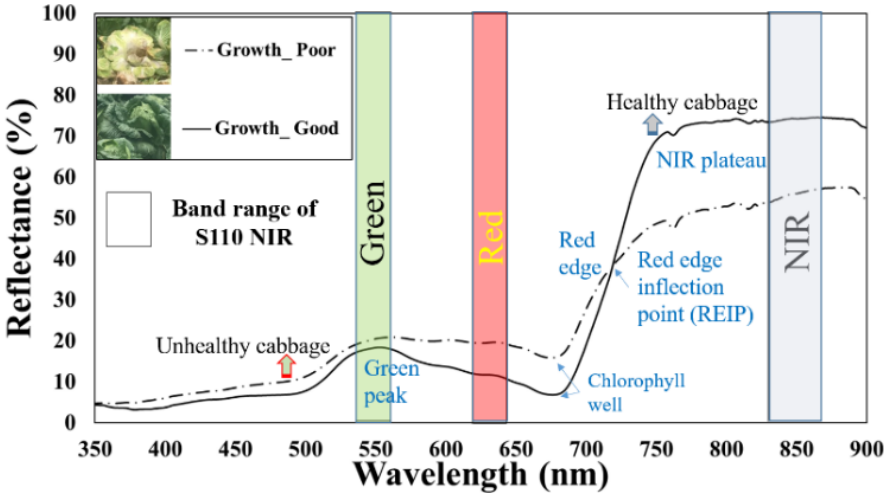
Figure 8. Comparison of the hyperspectral reflection characteristics of healthy and unhealthy cabbages and the wavelength range of data acquired by a UAV imaging sensor.